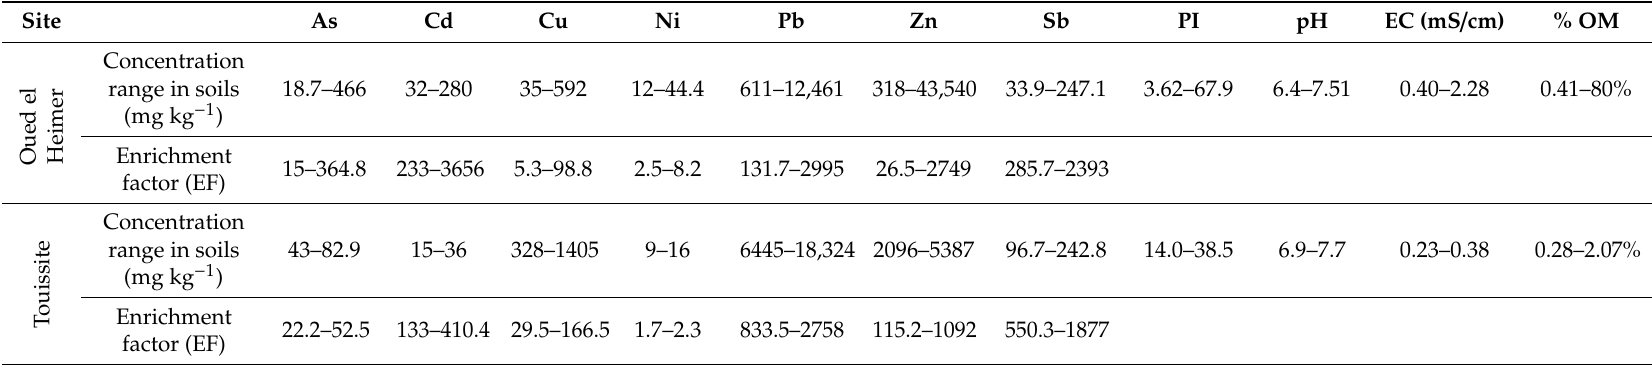
Table 1. Soil proprieties (pH, EC: Electrical conductivity, OM: Organic Matter) and range concentrations (mg kg − 1 DW) of As, Cd, Cu, Ni, Pb, Sb, and Zn in soils sampled from studied